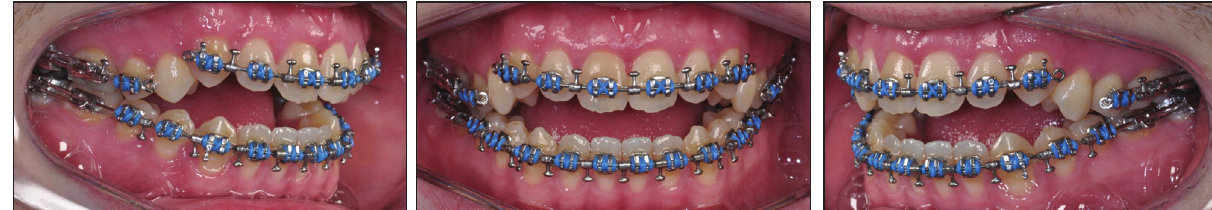
114551_ Figure 5. Upper archwire was sectioned immediately before surgery to allow intra-operative extraction of upper first premolars at the time of surgery. A